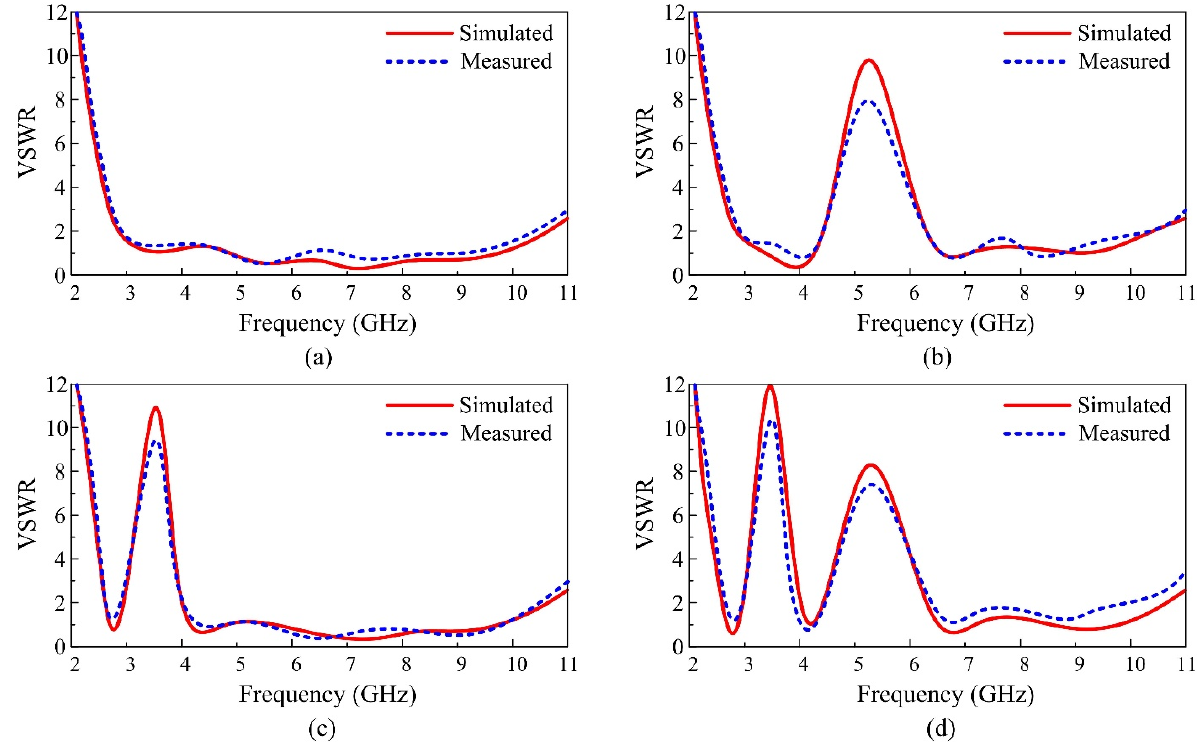
Figure 10. Comparison between simulated and measured VSWR for various switching states ( a ) case-10, ( b ) case-11, ( c ) case-00, and ( d ) case-01.